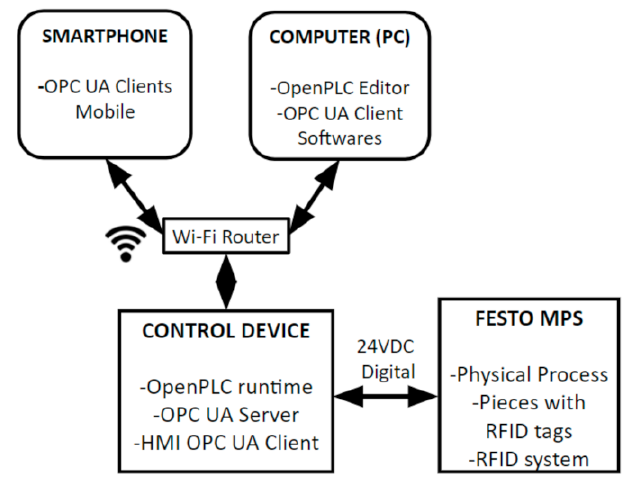
Figure 6. Connection diagram of the